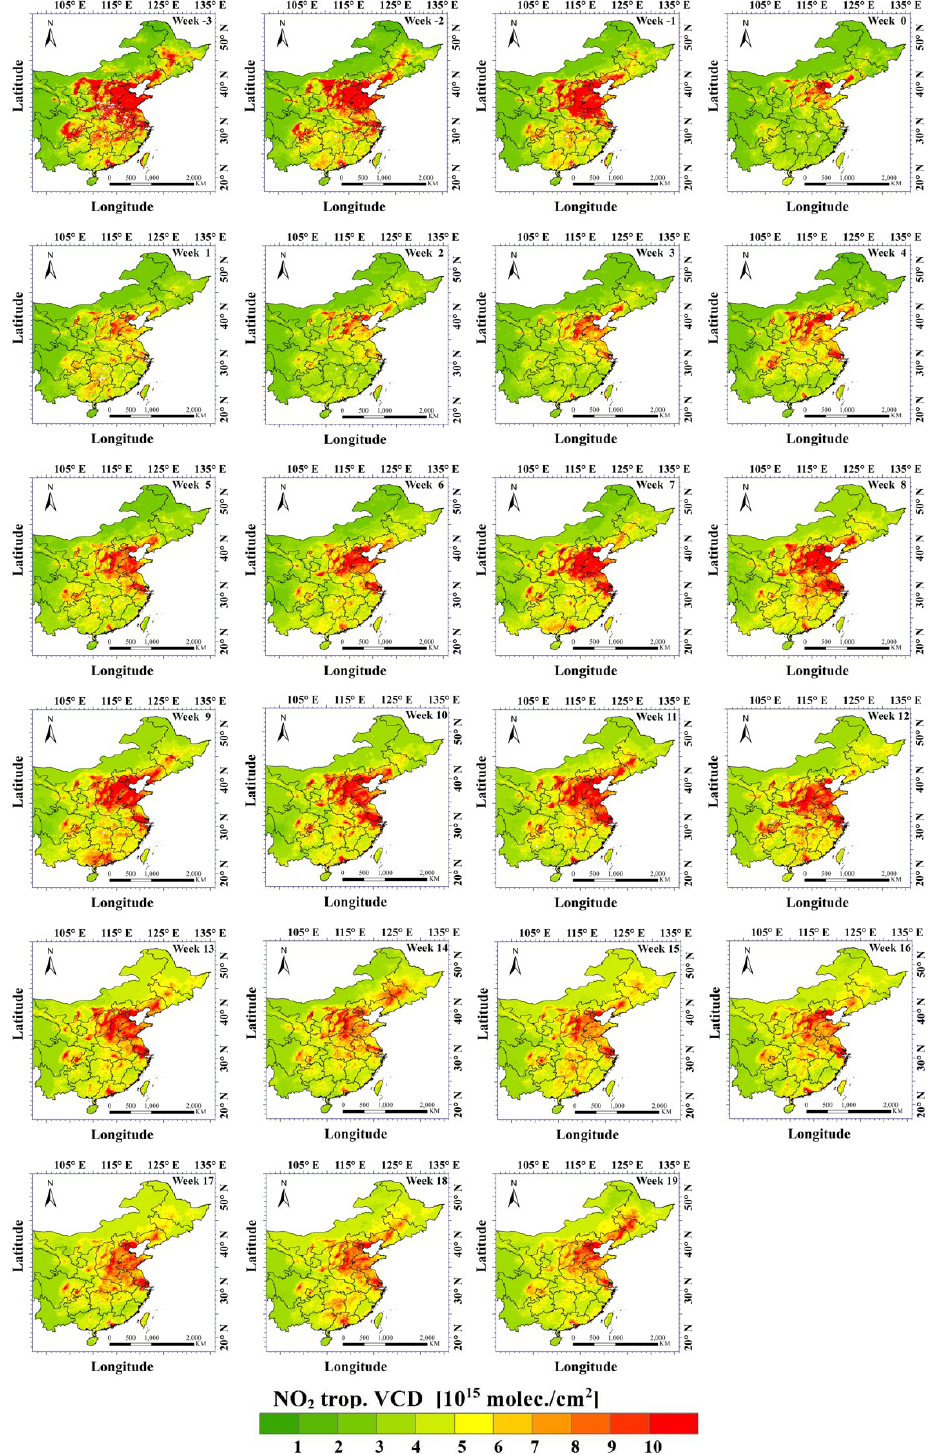
Figure 5. Maps of weekly averages of NO 2 TVCDs derived from TROPOMI data, for weeks − 3 to − 1 and week 0 (top row) and weeks 1–19 in the following rows. Note that week number refers to the 2020 Spring Festival, i.e., week 0 starts on Saturday 25 January 2020 (see also Table